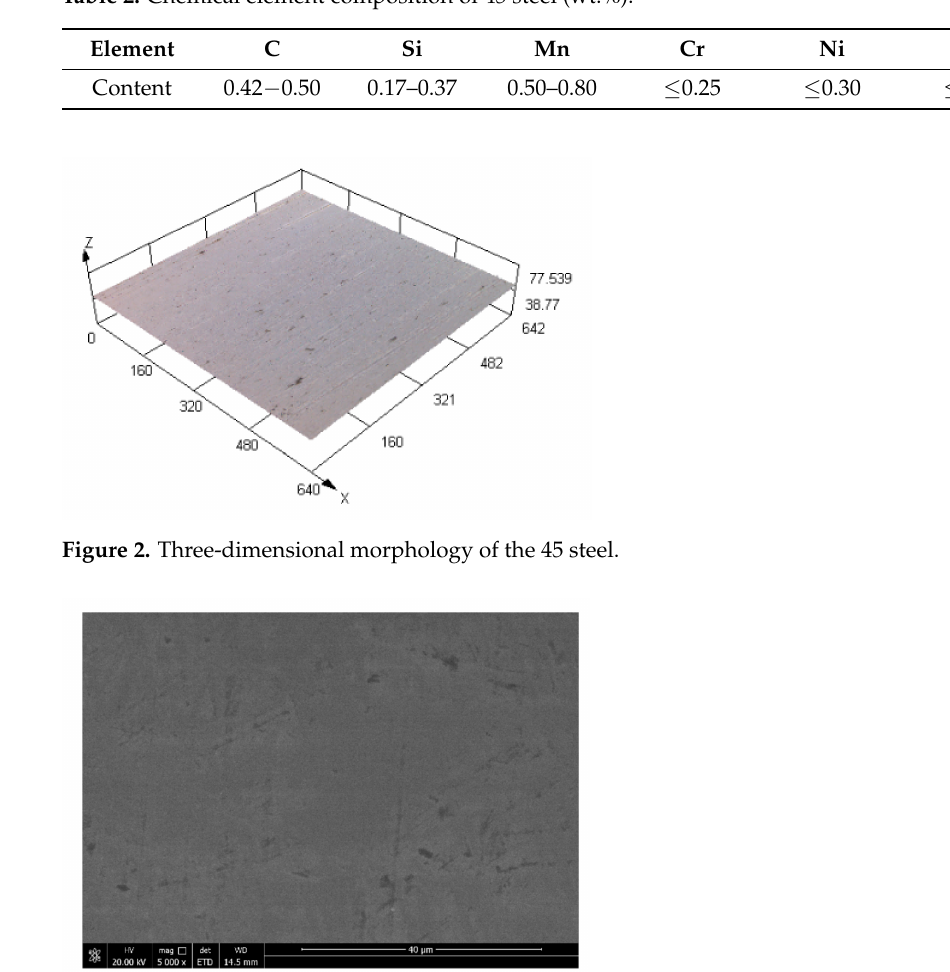
Table 2. Chemical element composition of 45 steel (wt.%).